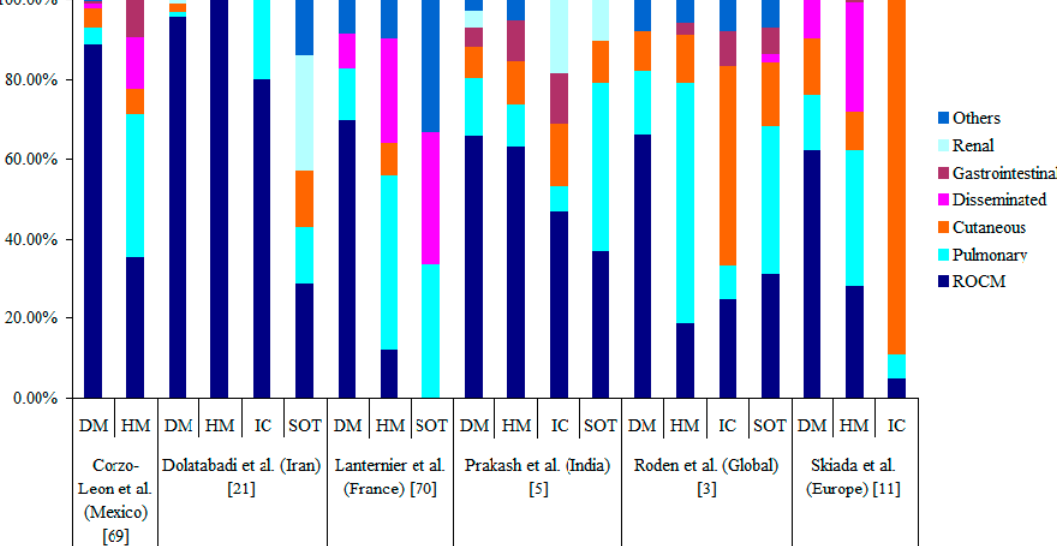
Figure 3. Clinical forms of mucormycosis in various underlying disease. Abbreviations: DM: Diabetes Mellitus, HM: Haematological Malignancy, IC: Immunocompetent and SOT- Solid Organ Transplant.